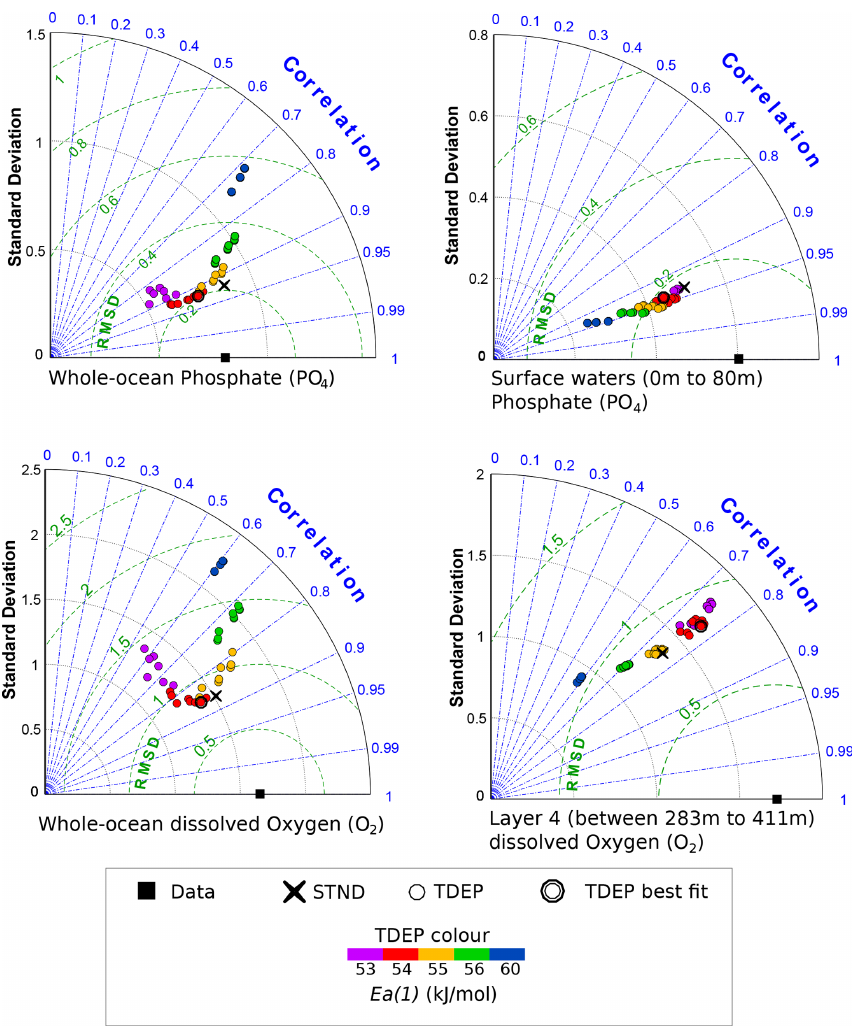
Figure 5. Taylor diagrams for the model fit to data for PO 4 and O 2 concentrations, showing the standard deviation (standard deviation is not normalised), correlation, and centred root means square difference (RMSD). Data from WOA 2009 (Levitus et al., 2010). The best-fit TDEP setting is double circled.